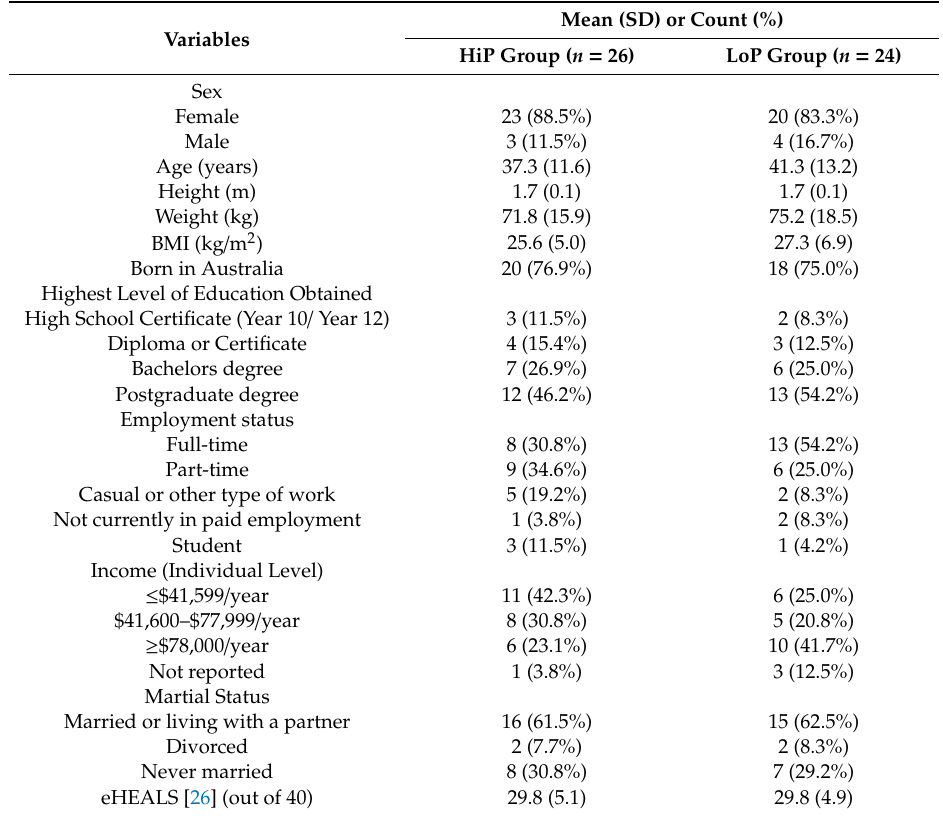
Table 1. Participant ( n = 50) baseline characteristics.